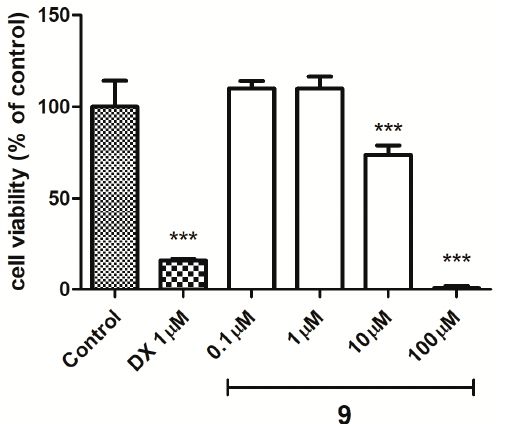
Figure 10. The viability of HepG2 cell line after incubation with compound 9 for 72 h. DX—doxorubicin. Control—1% DMSO in the cell culture media. The statistical significance was evaluated by a one-way ANOVA, followed by Bonferroni’s Comparison Test (*** p < 0.001 compared with control).